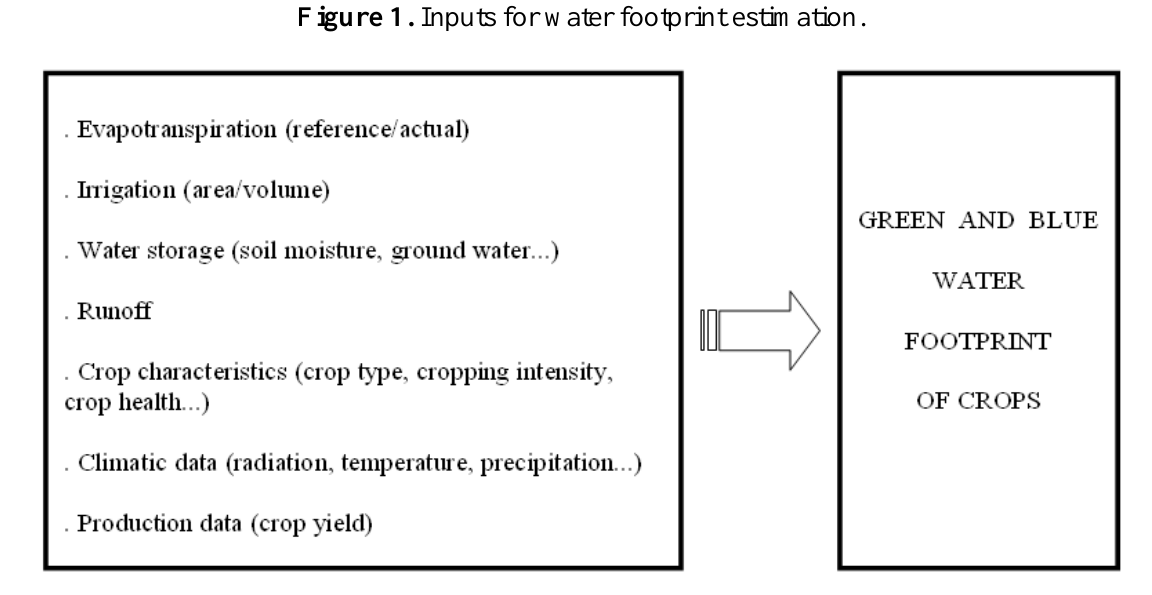
Figure 1. Inputs for water footprint